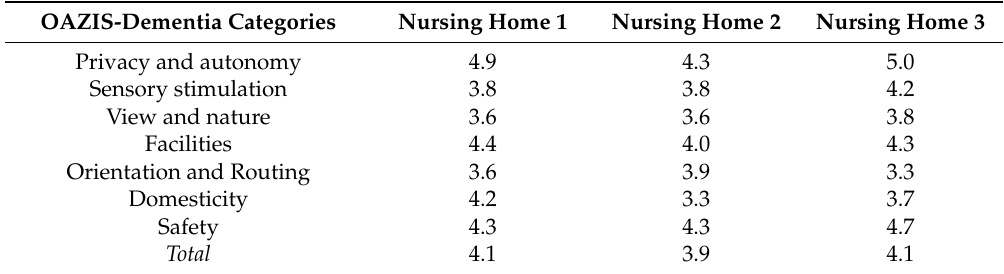
Table 5. Scores on the OAZIS-Dementia per nursing